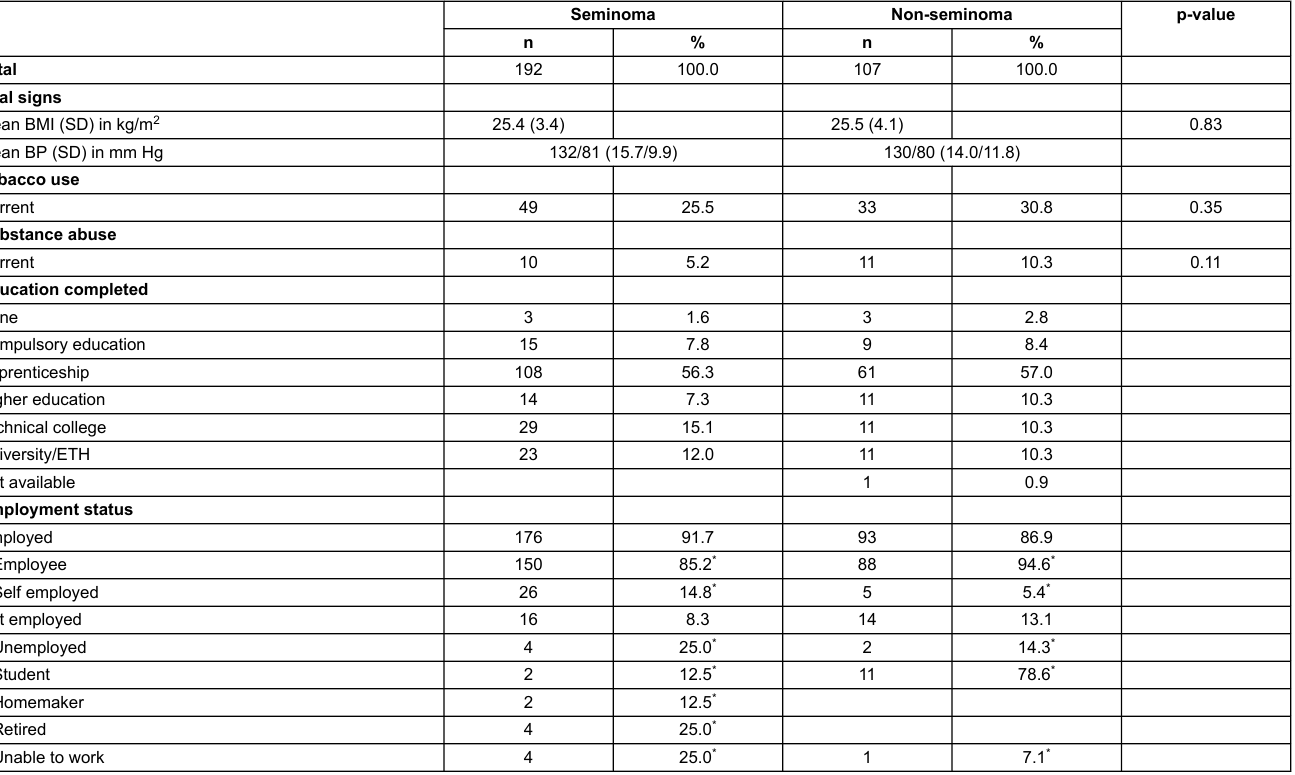
Table 2: Patient characteristics of the SAG TCCS cohort II.